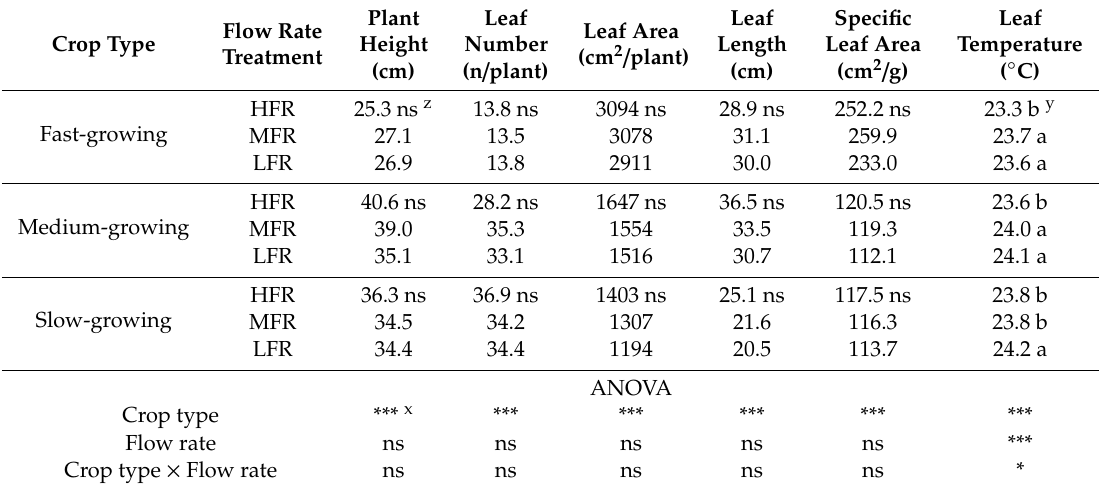
Table 4. Plant growth parameters of fast-, medium-, and slow-growing crops grown in aquaponics for 4 weeks at high (HFR, 3.3 m / day), medium (MFR, 2.2 m / day), and low (LFR, 1.1 m / day) flow